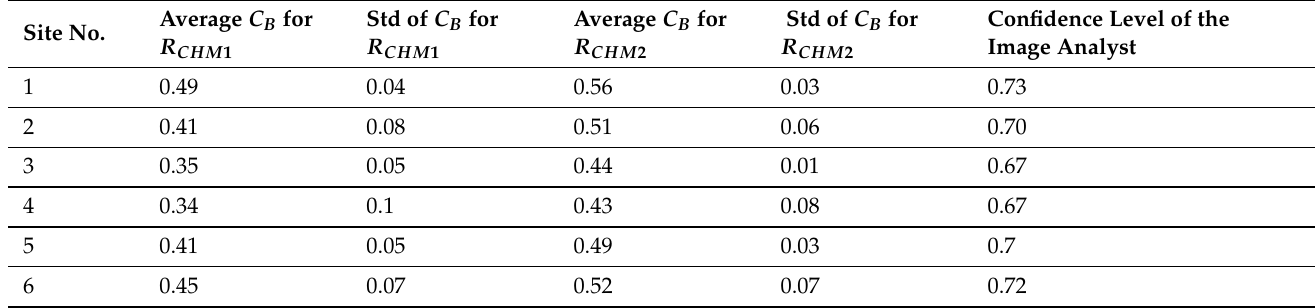
Table 5. C B values for the CHM segmentation using the JSEG workflow at two